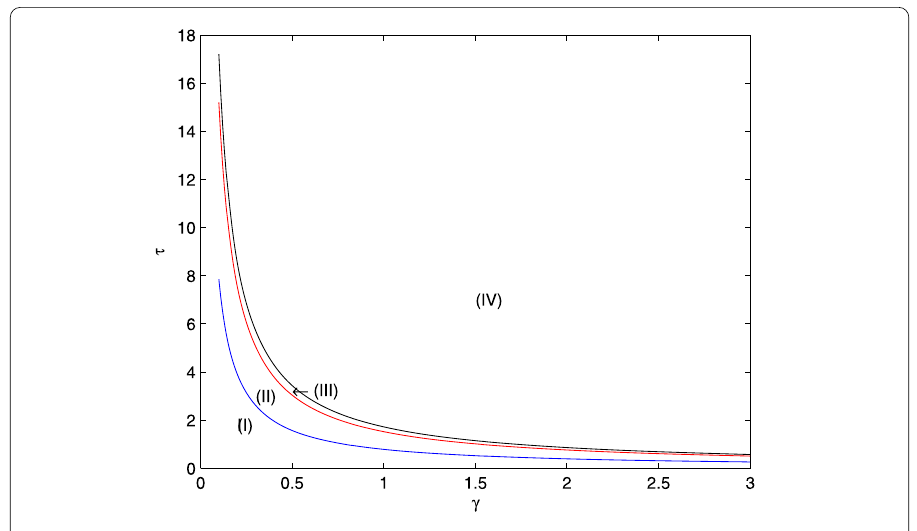
Figure 14 The different regions in the τ – γ parameter space with parameter β = 1